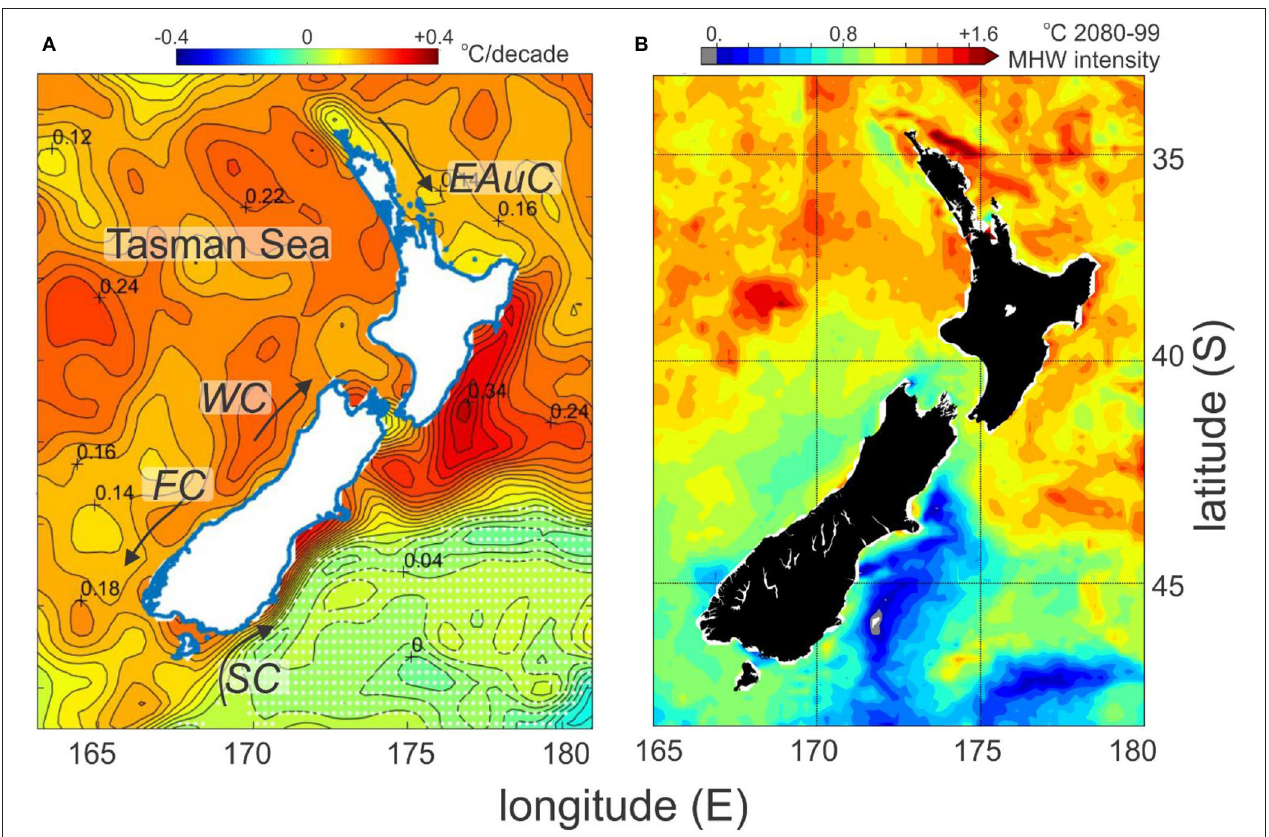
FIGURE 1 | (A) Recent past observations: the Aotearoa New Zealand region showing the measured decadal rate of warming since 1981 (after Sutton and Bowen, 2019) and main oceanographic features (Fiordland Current FC, Westland Current, East Auckland Current EAuC, Southland Current SC). (B) Future projections: NZESM (New Zealand Earth System Model) ensemble projected changes of median MHW intensity relative to 1995–2014 NOAA OI-SST observations for SSP (Shared Socioeconomic Pathways) 4.5 in 2080–2099 (see Behrens et al.,